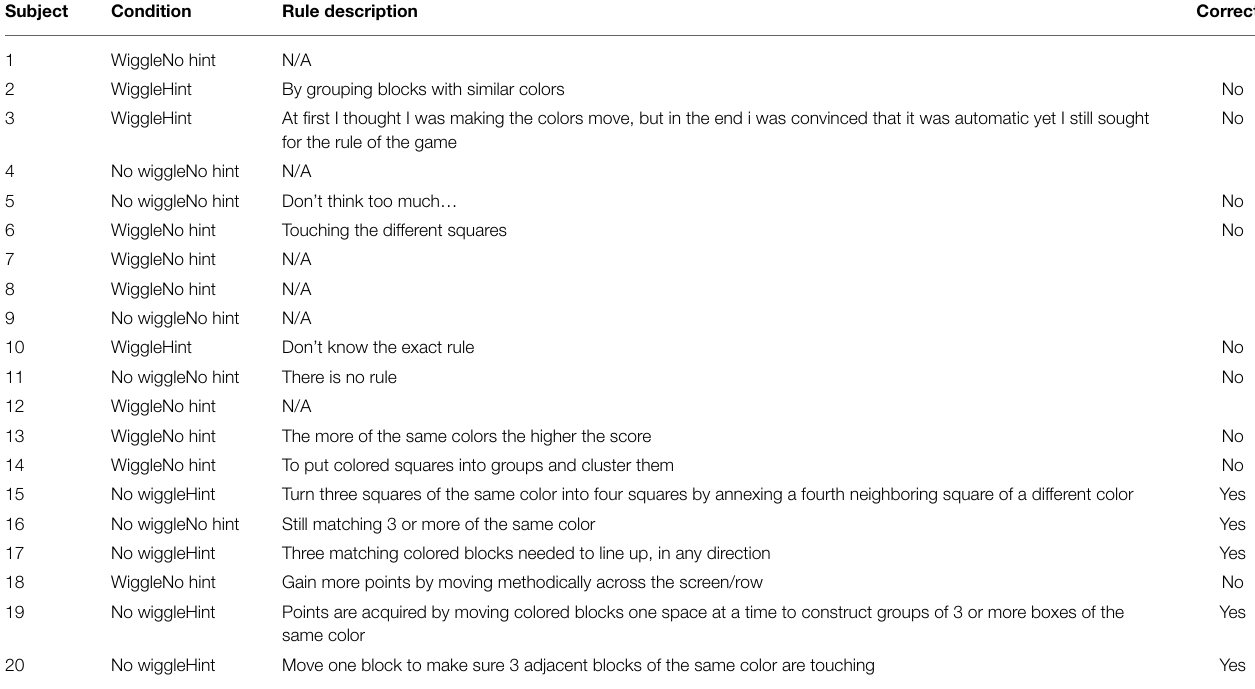
TABLE 3 | Verbatim self-reported rule descriptions following Session 2 of game play, by